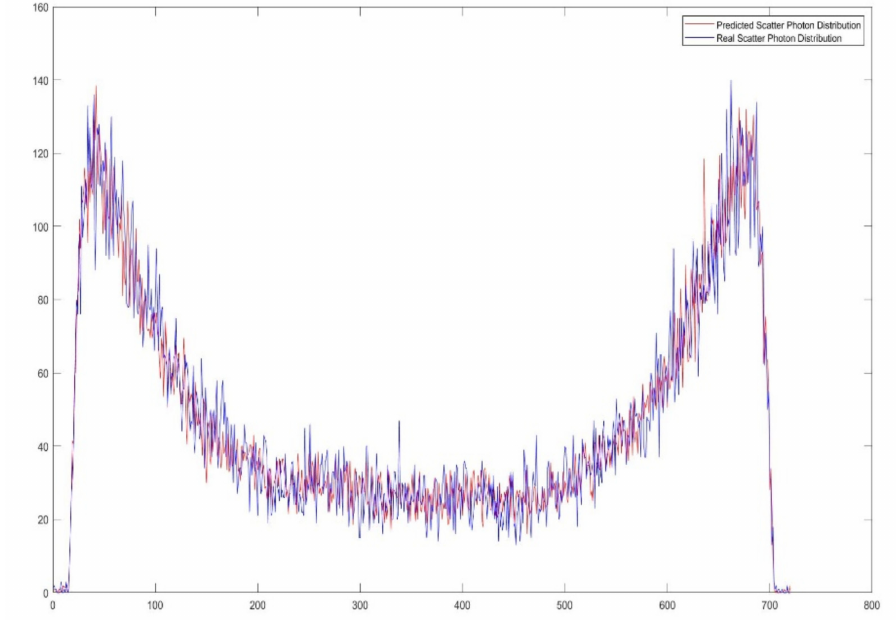
Figure 12. Cross-section lines at the 360th row of the true scattered photon distribution and the predicted scattered photon distribution in the energy region of interest.